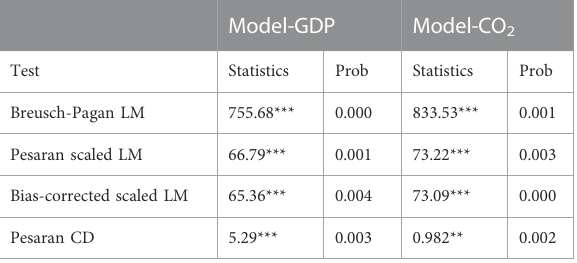
TABLE 2 Results of cross-sectional dependency